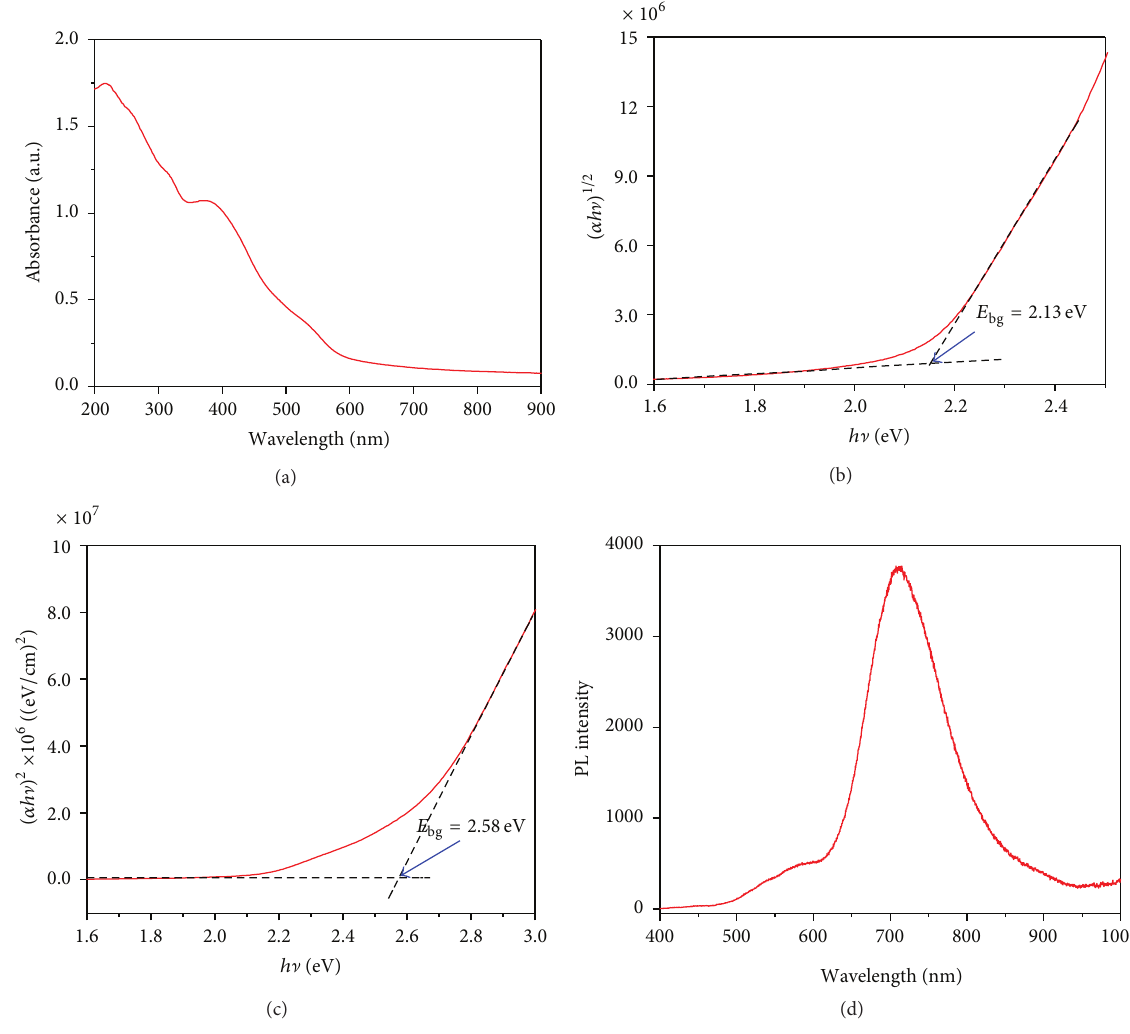
Figure1:(a)UV-visibleabsorptionspectrumofcolloidal 𝛼 -Fe 2 O 3 nanoparticles.Plotsof(b) (𝛼ℎ ] ) 2 versus ℎ ] obtainedduetodirecttransition and(c) (𝛼ℎ ] ) 1/2 versus h ] obtainedduetoindirecttransitionof 𝛼 -Fe 2 O 3 nanoparticlesand(d)PLspectrumofcolloidal 𝛼 -Fe 2 O 3